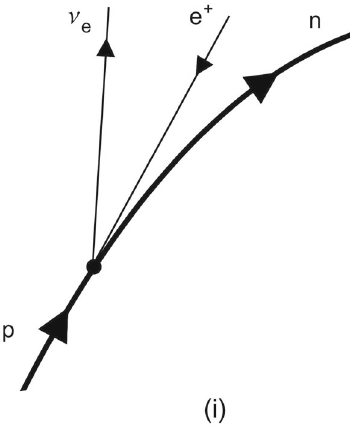
Fig. 1 Inverse β -decay in the laboratory frame in the absence of flavor oscillations (time flows in the vertical